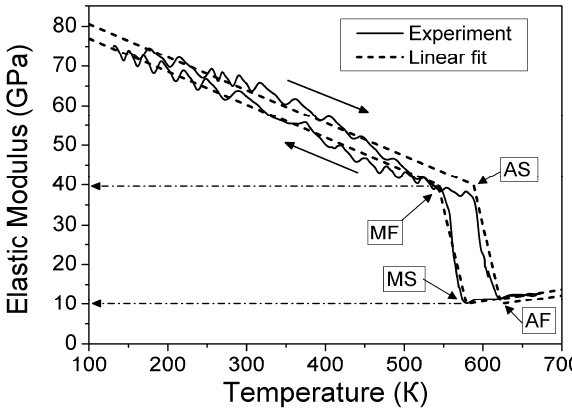
Mn Ga single crystal. 57.5 22.5 20.0